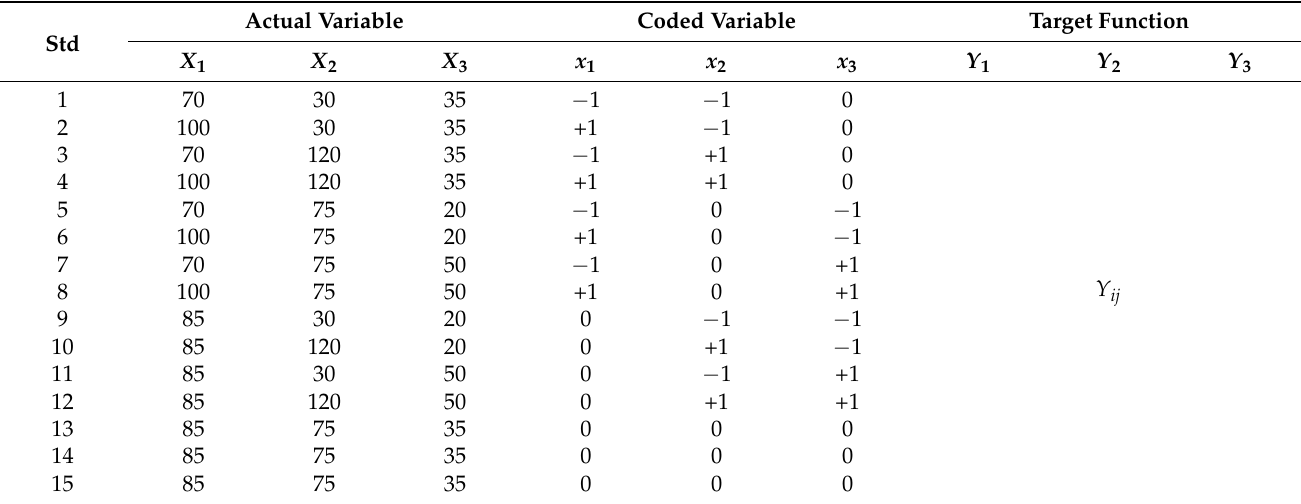
Table 5. Experiment design and the